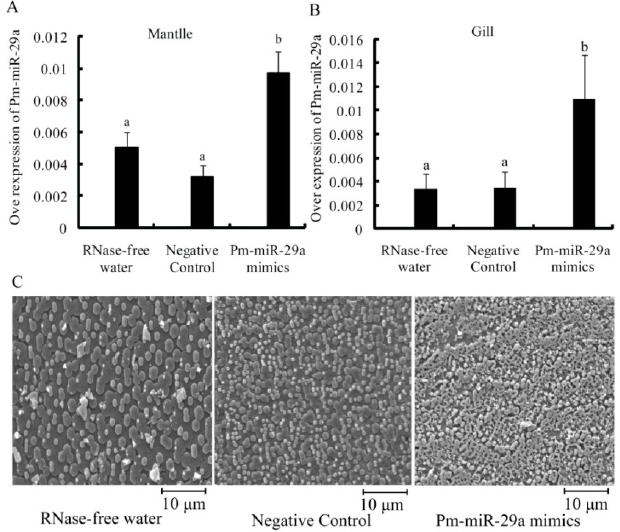
Figure 3. Functional analysis of Pm-miR-29a.The over-expression of Pm-miR-29a in the mantle ( A ) or gill ( B ) after Pm-miR-29a mimic injection were all detected by stem loop qRT-PCR. U6 snRNA was used as the internal reference gene. Different letters mean a significant difference ( p < 0.05). Error bars correspond to mean ± SD; and ( C ) scanning electron microscope (SEM) images of the nacre after Pm-miR-29a mimic injection. The bars are 10 μ m in the nacre images.